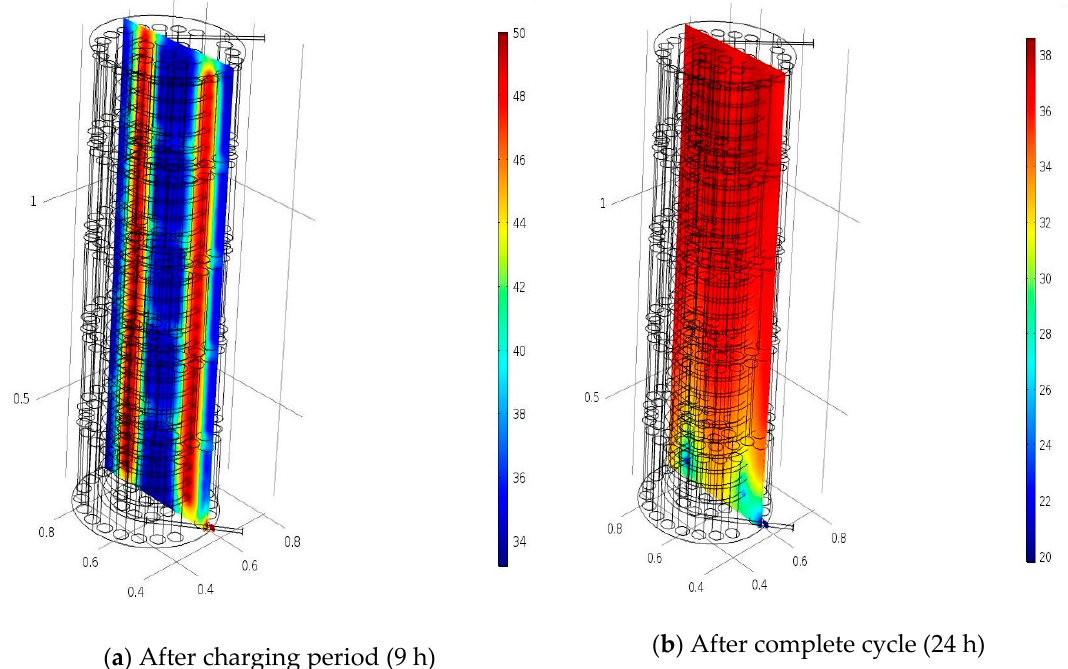
Figure 8. Mid-plane temperature contours after charging and discharging periods.